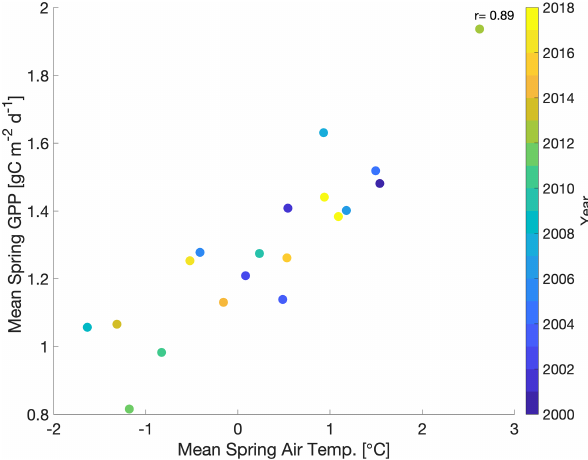
Figure 2. Scatterplot of mean spring (March–May) GPP with mean spring air temperature with the color bar showing the corresponding year (2000–2018). r is Pearson’s correlation